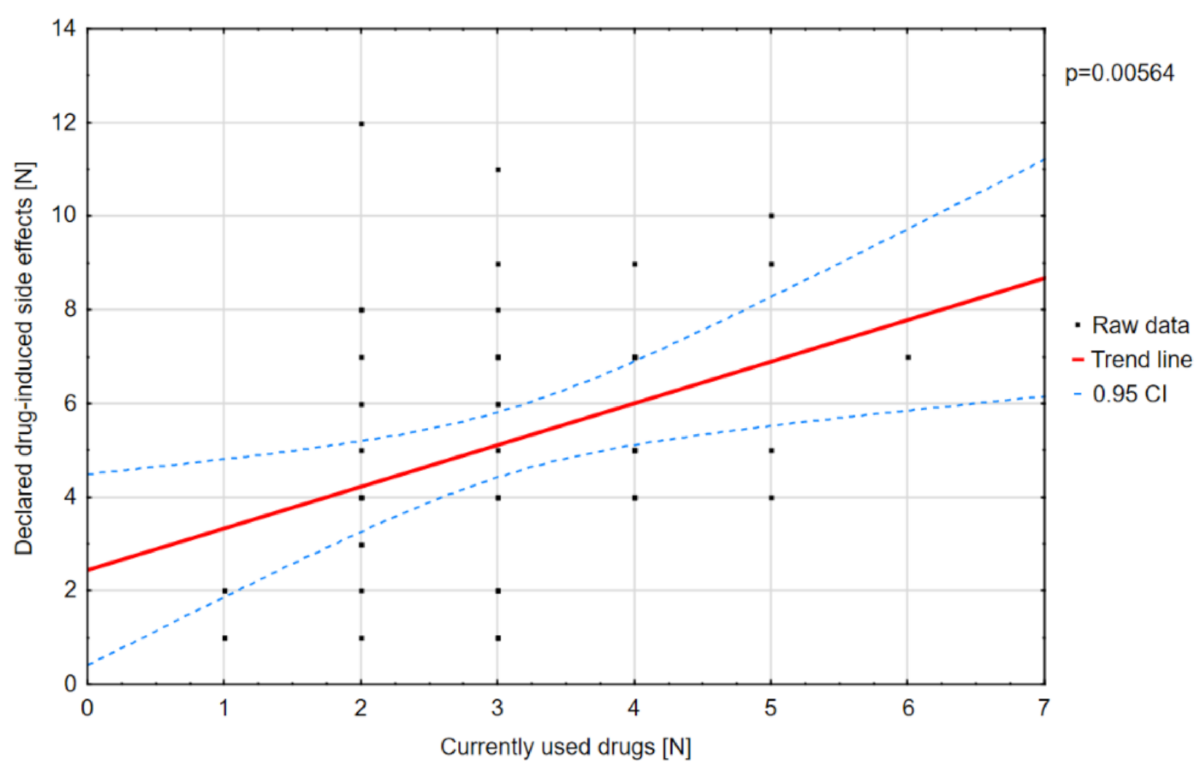
Figure 3. Reported drug-induced adverse effects depending on the number of drugs used.